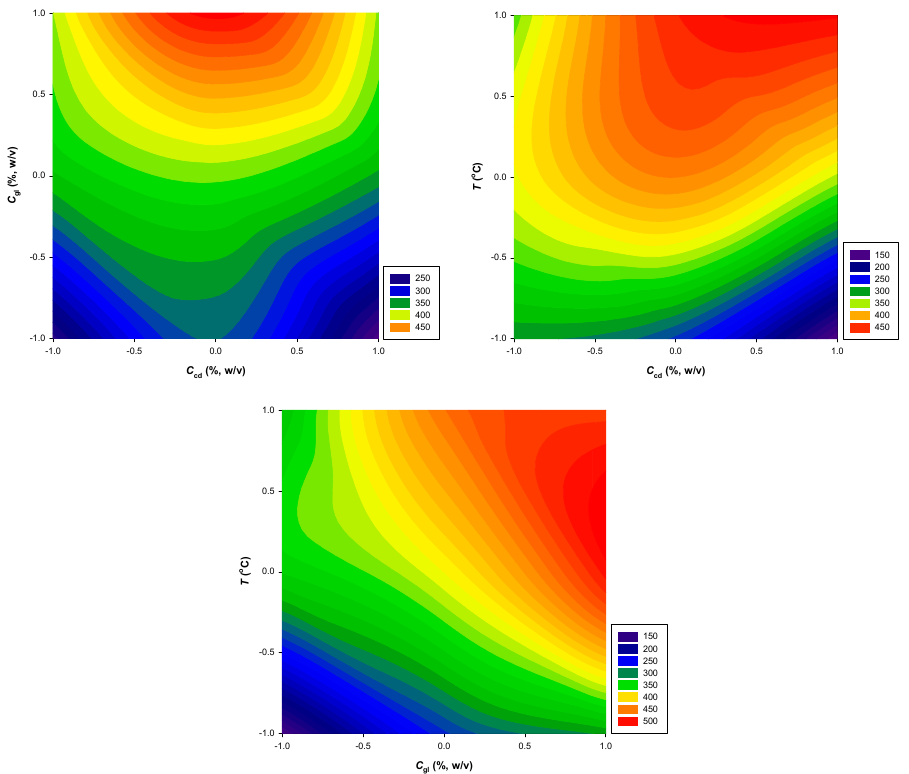
Figure 3. Contour plots illustrating the effect of the independent variables considered on the P R . The upper left, upper right and lower plots show the effect of simultaneous variation of C gl and C CD , T and C CD and T and C gl , respectively (numbers on the axes correspond to coded values). Extractions of oak acorn husks were carried out under stirring at 600 rpm, for 180 min and a liquid-to-solid ratio of 50 mL·g − 1 .